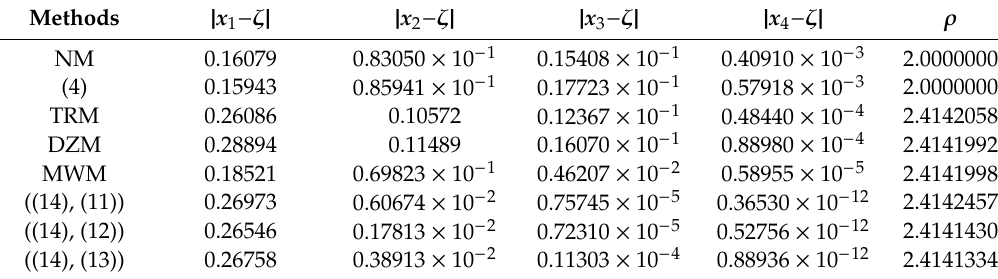
Table 8. Numerical results for function f 8 ( x ) .